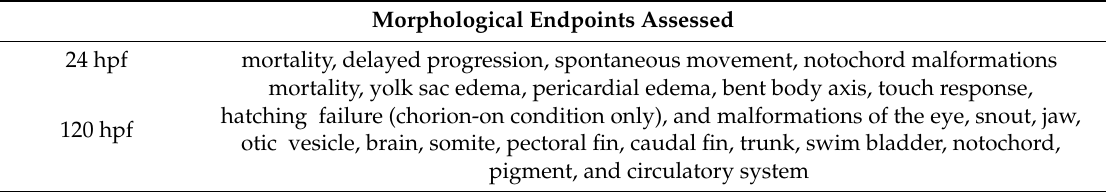
Table 3. Morphology endpoints assessed at 24 and 120 h post